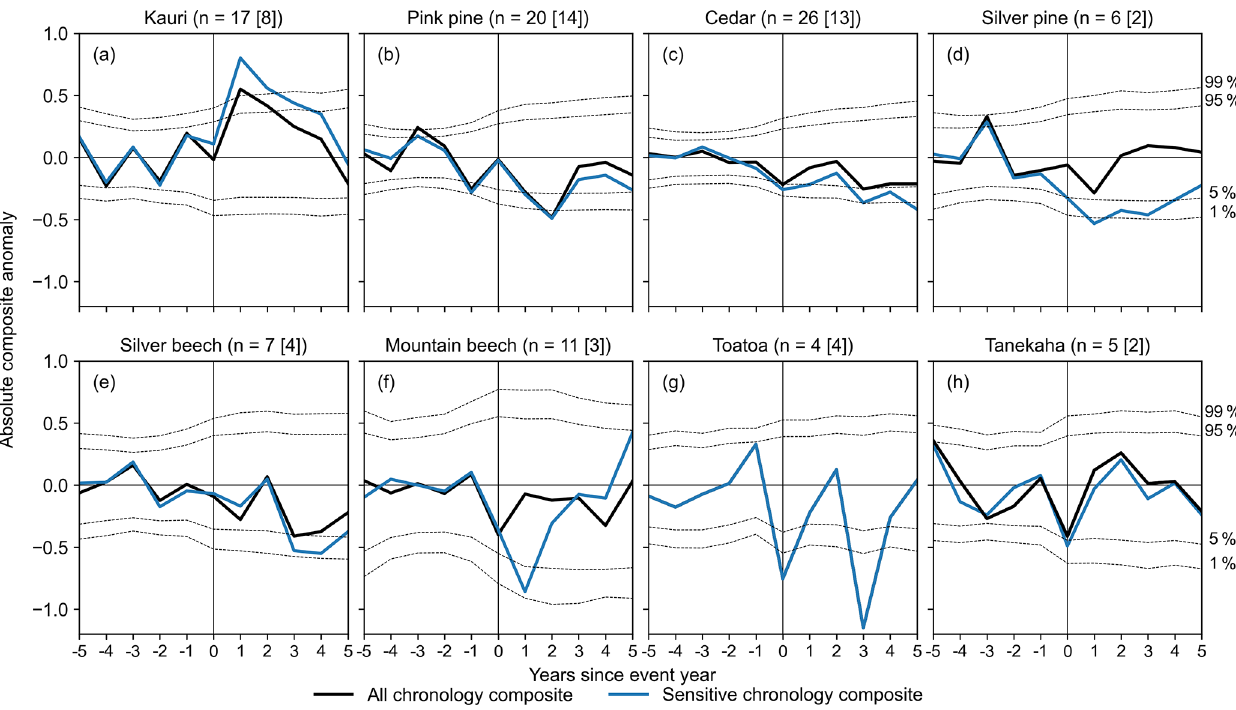
Figure 3. Mean chronology departures 5 years before and 5 years after the 13 largest eruption years (year 0), separated by tree species. The chronologies contributing to the species-wide composite are shown in black, with the number of chronologies indicated in parentheses. The sensitive chronology composite in shown in blue and the number of contributing chronologies is shown in brackets. Significance bands (dotted grey lines) are the 1st, 5th, 95th, and 99th percentile of 10000 random samples of non-event years from the species-wide